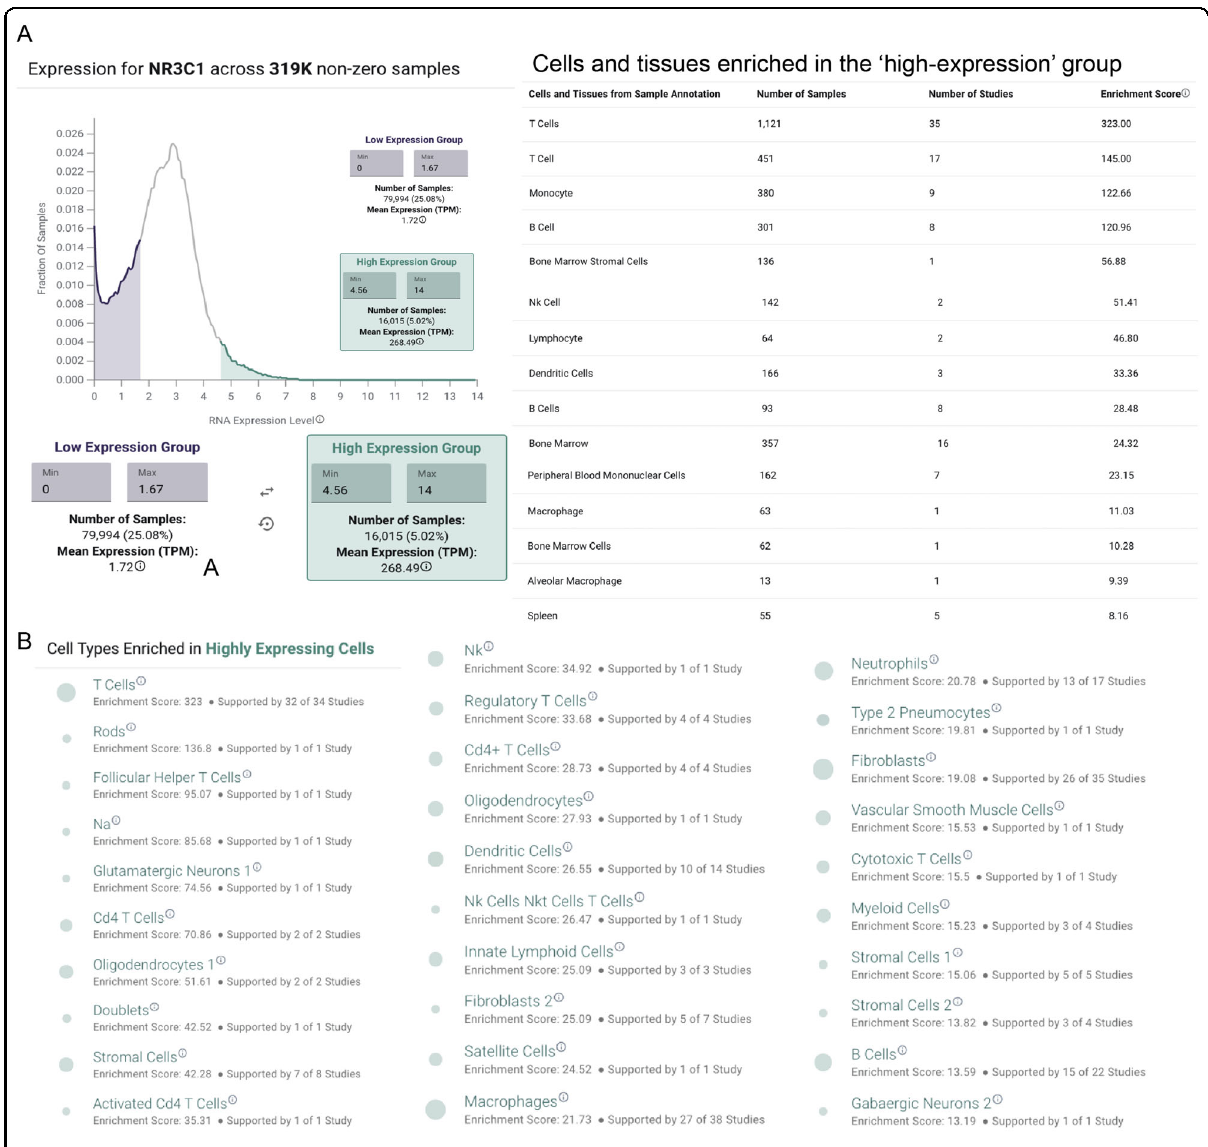
Fig. 3 Analysis of bulk tissue RNA sequencing data from gene expression omnibus reveals increased NR3C1 expression in human immune cells. A Expression pro fi le of NR3C1 across ~319,000 non-zero expressing bulk RNA-sequencing samples from the gene expression omnibus. Cells of the immune system are enriched among the highest expressing samples, including both lymphocytes and myeloid cells. B Single-cell RNA- sequencing expression pro fi le of NR3C1 across ~1.9 million individual human-derived cells. Cells of the immune system are enriched among the highest expressing samples, including both lymphocytes and myeloid